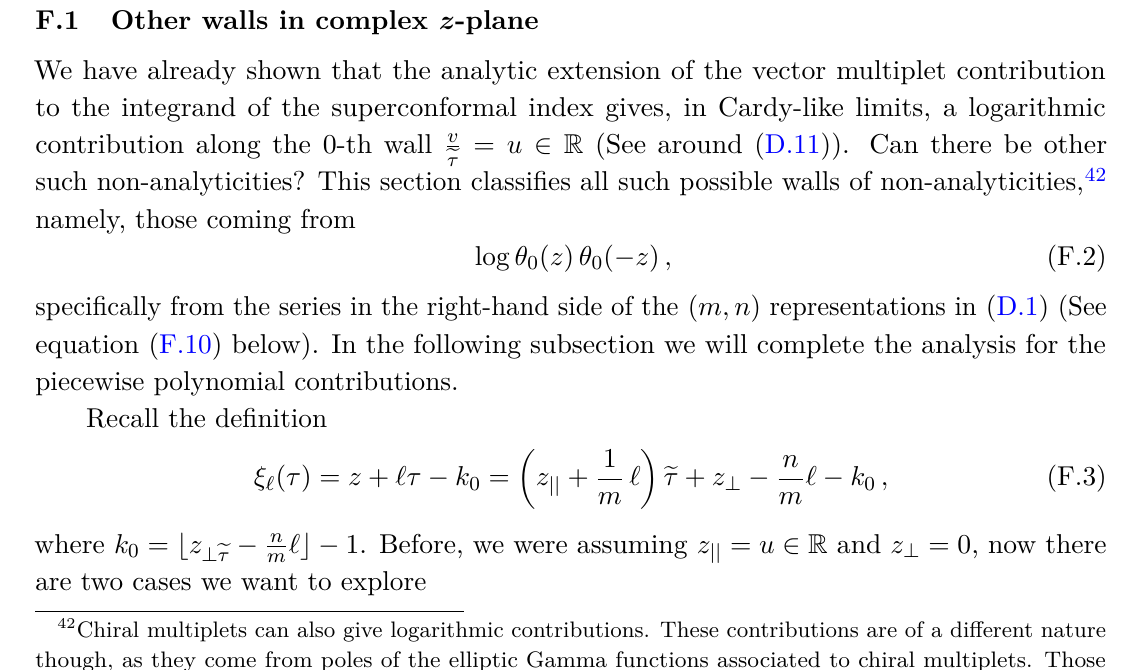
Figure 10 . Numerical plot of the absolute value (Abs) and argument(Arg) of the quotient between the left and right-hand sides of equation (E.11) in the case N = k = 2 and 1 Note that for 1 −→ 0 the result tends to one, as predicted by 2 δ